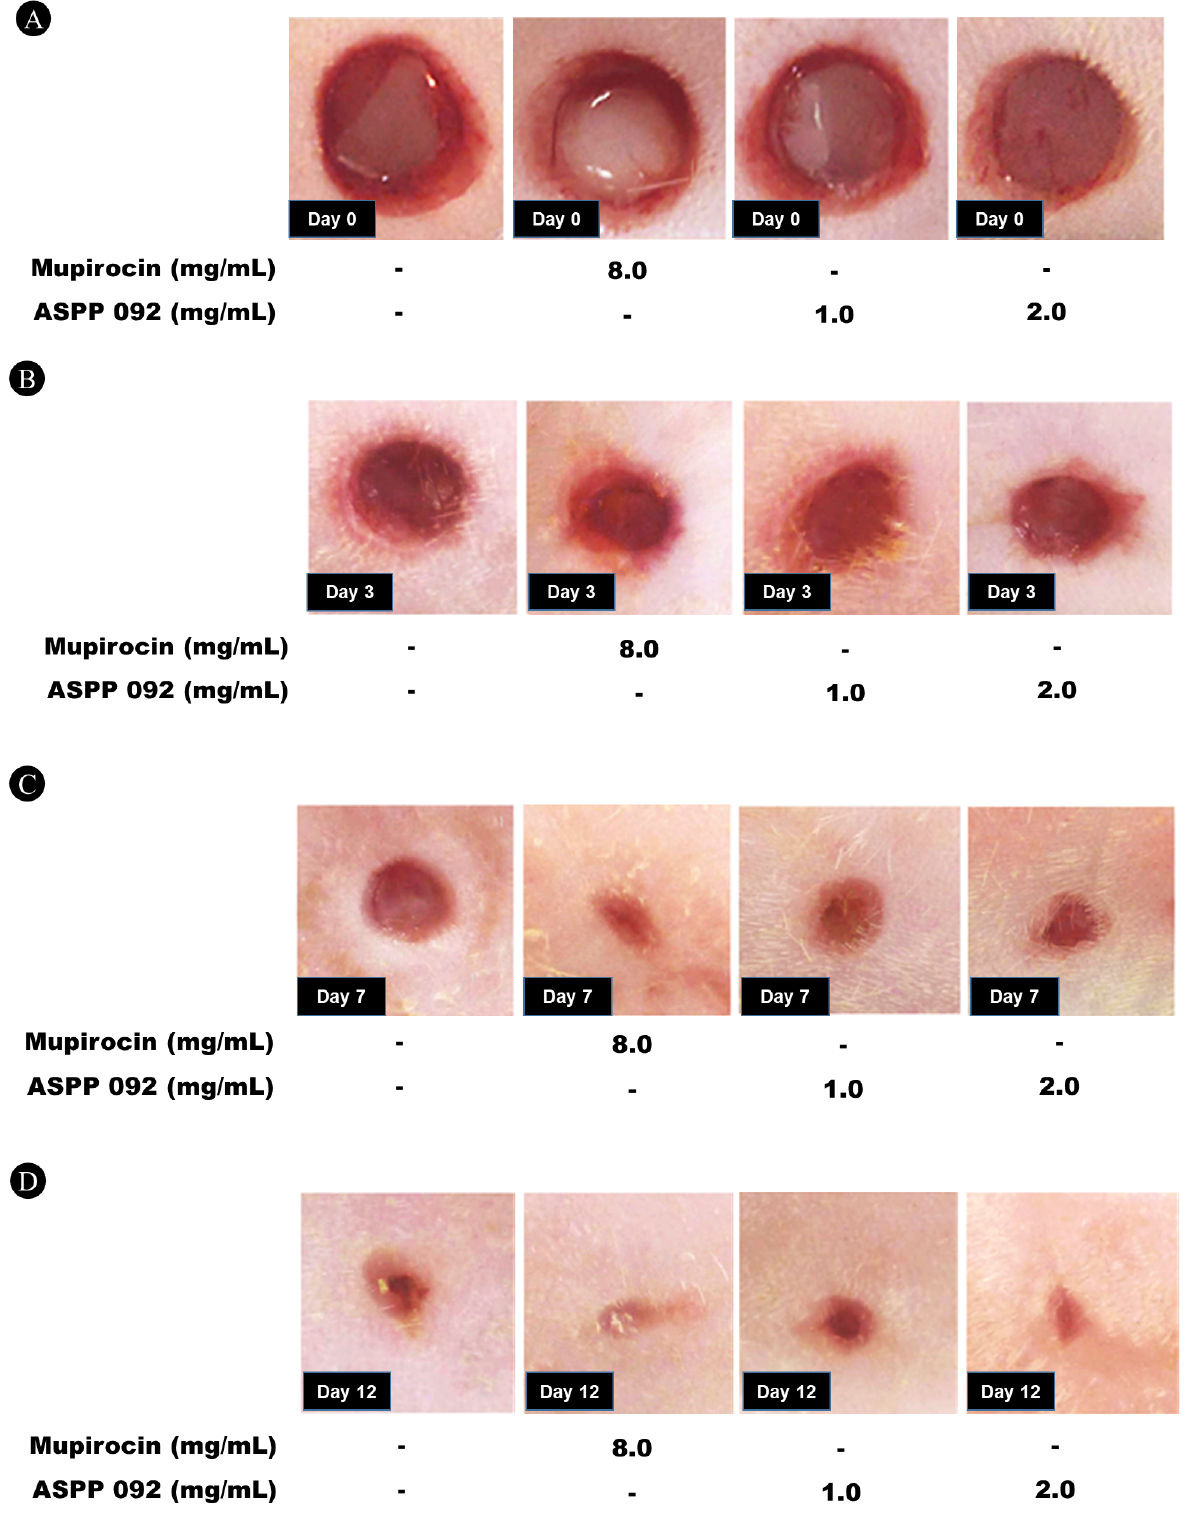
Figure 2. The morphological changes in the wounds when the experimentally induced wounds were treated with mupirocin or ASPP 092 at concentrations of 1 mg/mL and 2 mg/mL. A vehicle control group was also maintained. The effect of these treatments at different time points, including ( A ) Day 0, ( B ) Day 3, ( C ) Day 7, and ( D ) Day 12, are represented.